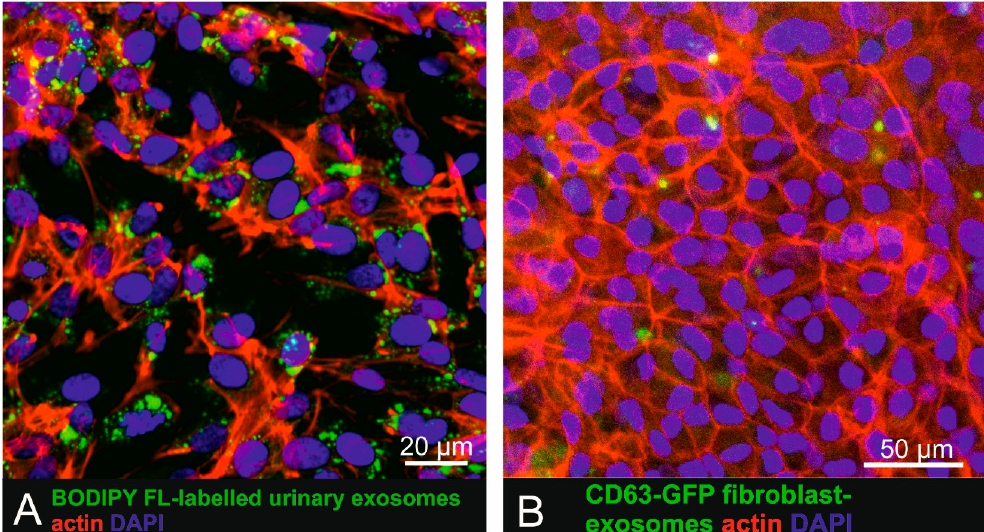
Figure 3. Uptake of urinary BODIPY-labelled small EVs and CD63-GFP tagged fibroblast-derived small EVs in human iPSC derived RPE cells. ( A ) Incubation of iPSC-derived RPE cells with BODIPY- labelled small EVs. ( B ) iPSC-derived RPE cells exposed to CD63-GFP fluorescent tagged primary fibroblast-derived small EVs also showed intracellular exosome